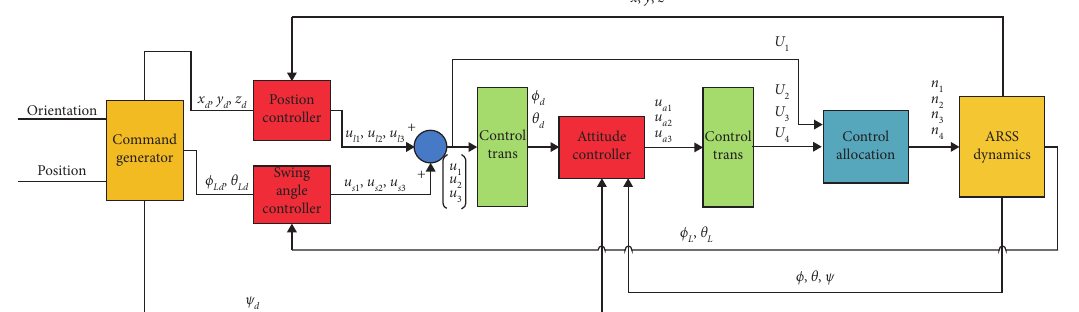
Figure 3: The control diagram of